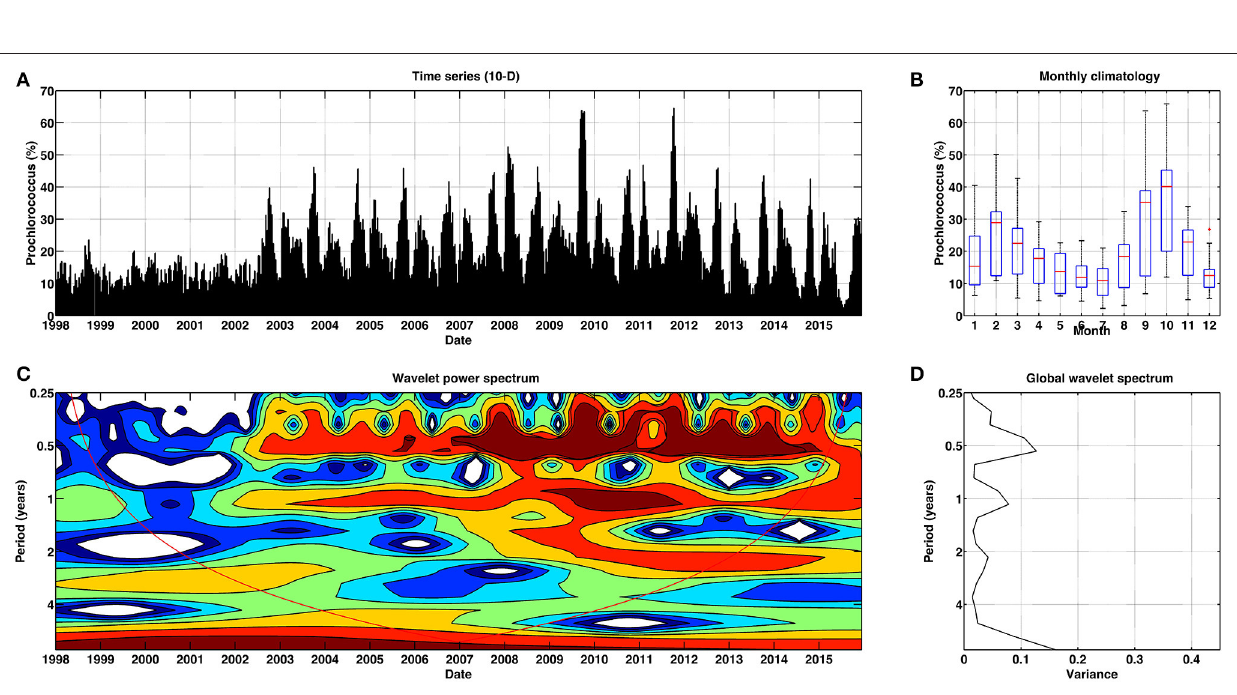
Frontiers in Marine Science | www.frontiersin.org